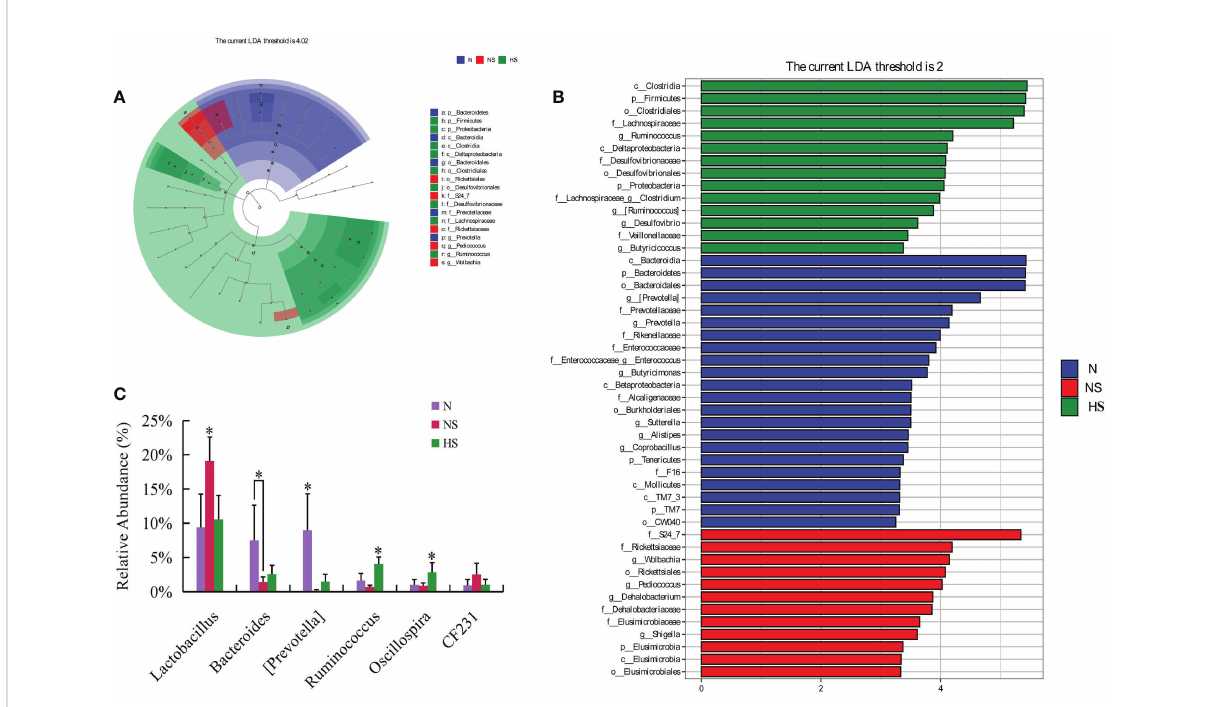
FIGURE 6 (A) LEfSe taxonomic cladogram. The colored nodes from the inner circle to the outer circle represented the hierarchical relationship of all taxa from the phylum to the genus level. Taxa enriched in HS, NS, and N group are shown in green, red, and blue, respectively. The non-signi fi cant changes were colored white. The diameter of each small circle represents the taxa abundance. (B) Enriched taxa with a linear discriminant analysis score = 2 are shown in the histogram. The longer bars of the histogram represent the more signi fi cant phylotype microbiota upon comparison. (C) Species with signi fi cant differences at the genus level. Unmarked data indicate no signi fi cant difference ( P > 0.05); * P < 0.05; n =